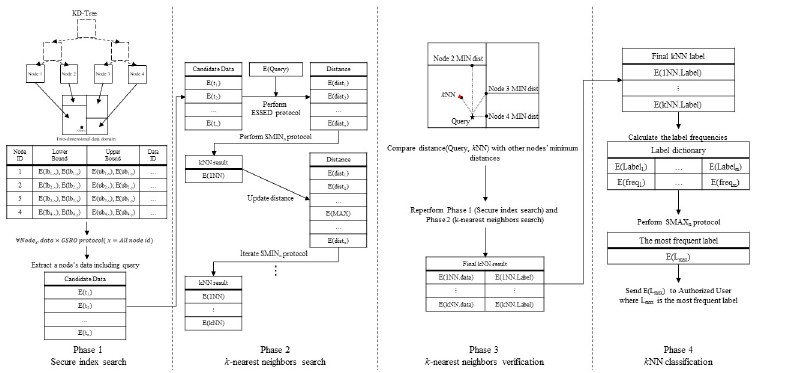
Fig 3. Proposed parallel kNN classification